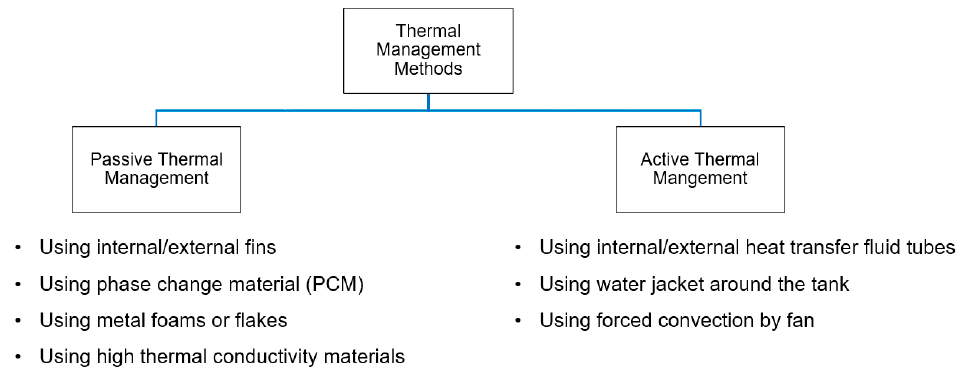
Figure 2. Thermal management methods for the MH